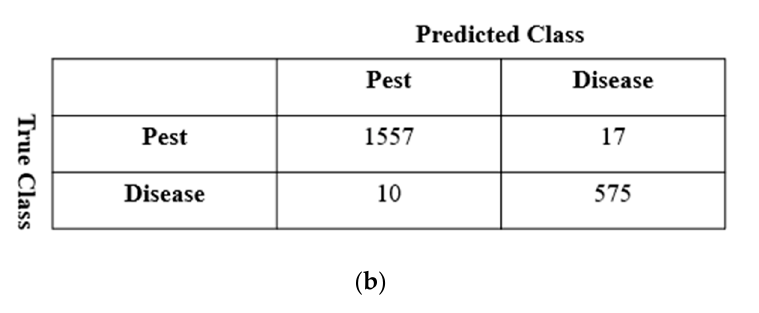
Figure A1. The confusion matrix for the test set. ( a ) test result of each class, ( b ) prediction for pest and disease